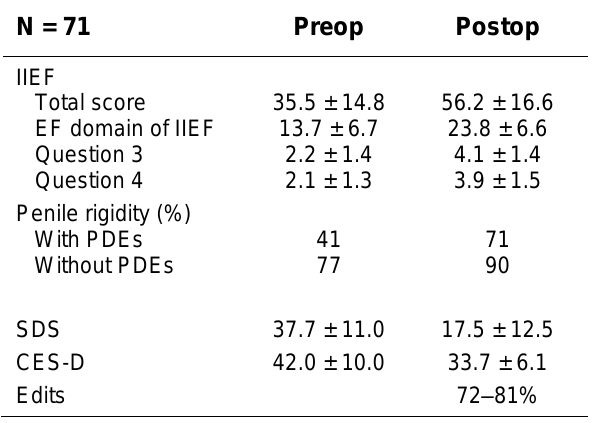
MABS: Long-Term Outcomes Using Validated